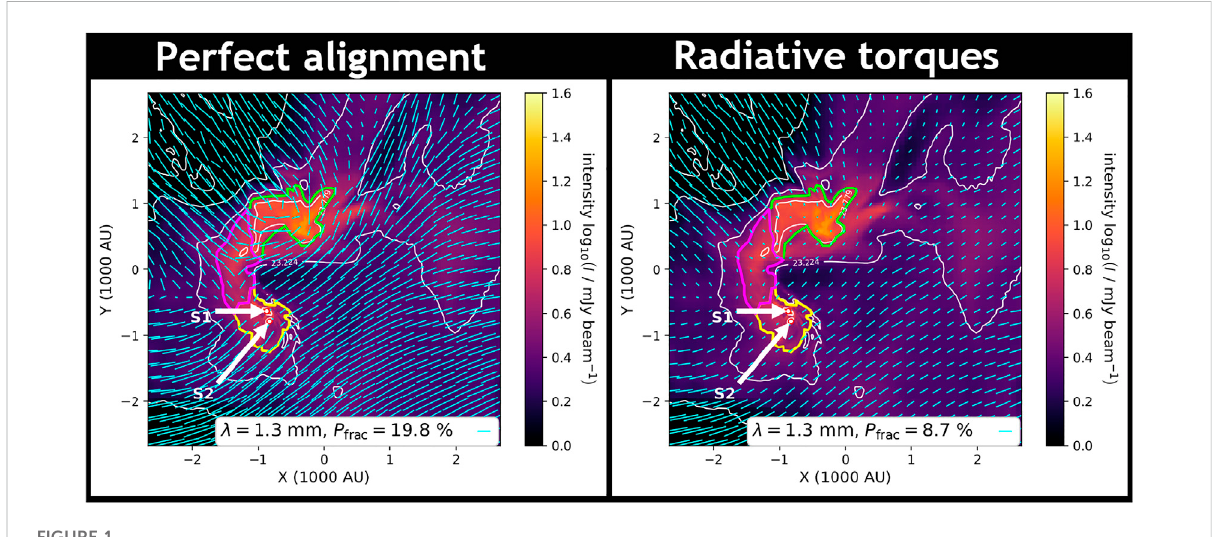
FIGURE 1 Example synthetic maps of the 1.3 mm dust continuum emission from an MHD protostellar formation model, using the POLARIS radiative transfertool.Overlaidarethepolarizationvectorsrotatedby90 ° ,obtainedeitherconsideringperfectalignmentofthedustgrains(right)orRATgrain alignment (left), from Kuffmeier et al.